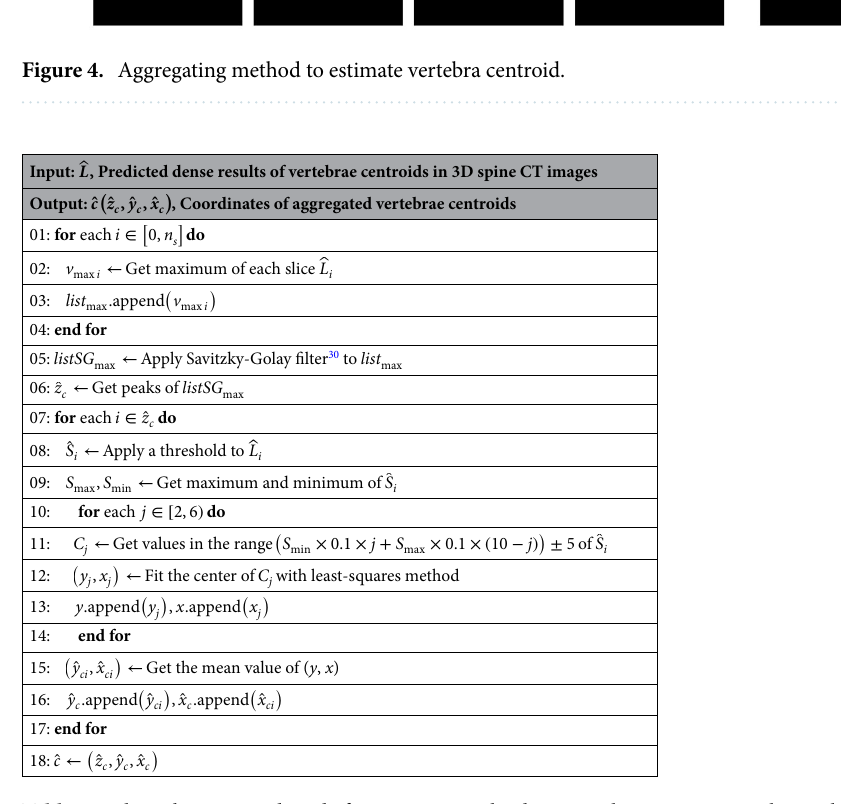
Table 2. Algorithm 2: Pseudocode for aggregating the dense results to estimate each vertebra